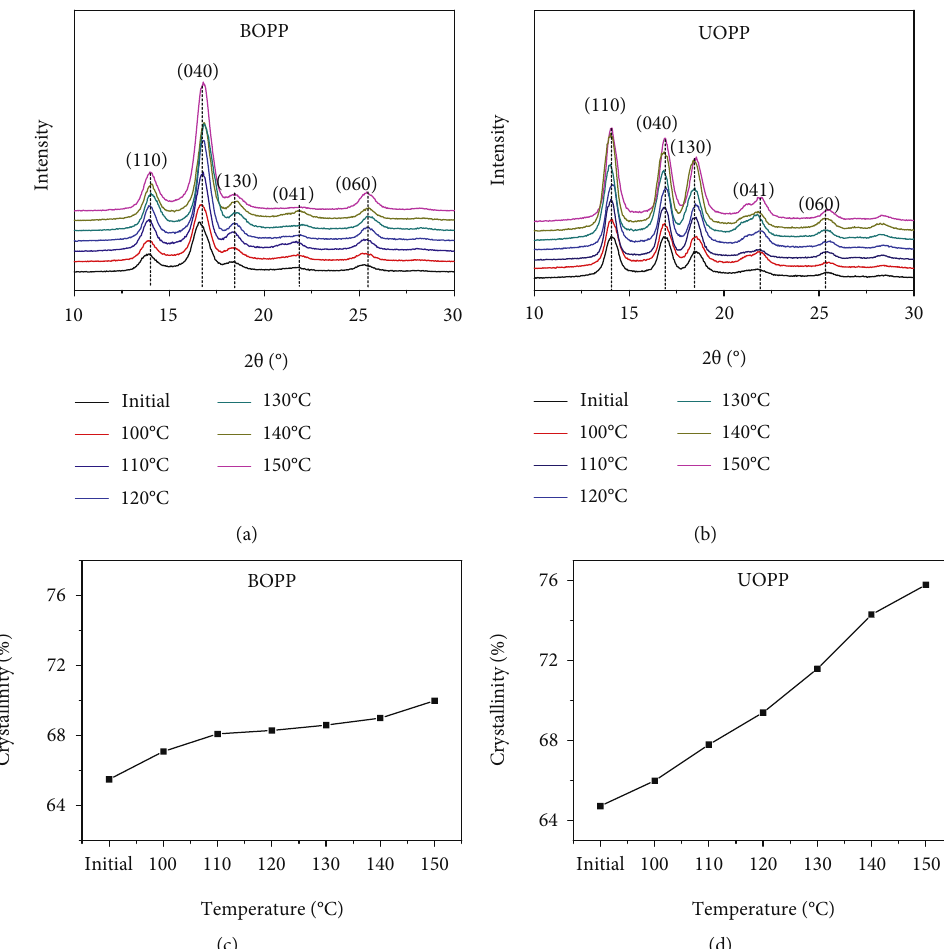
Figure 4: WAXD pro fi les and crystallinity of PP fi lms. WAXD pro fi les of (a) BOPP fi lms and (b) UOPP fi lms. Crystallinity of (c) BOPP fi lms and (d) UOPP fi